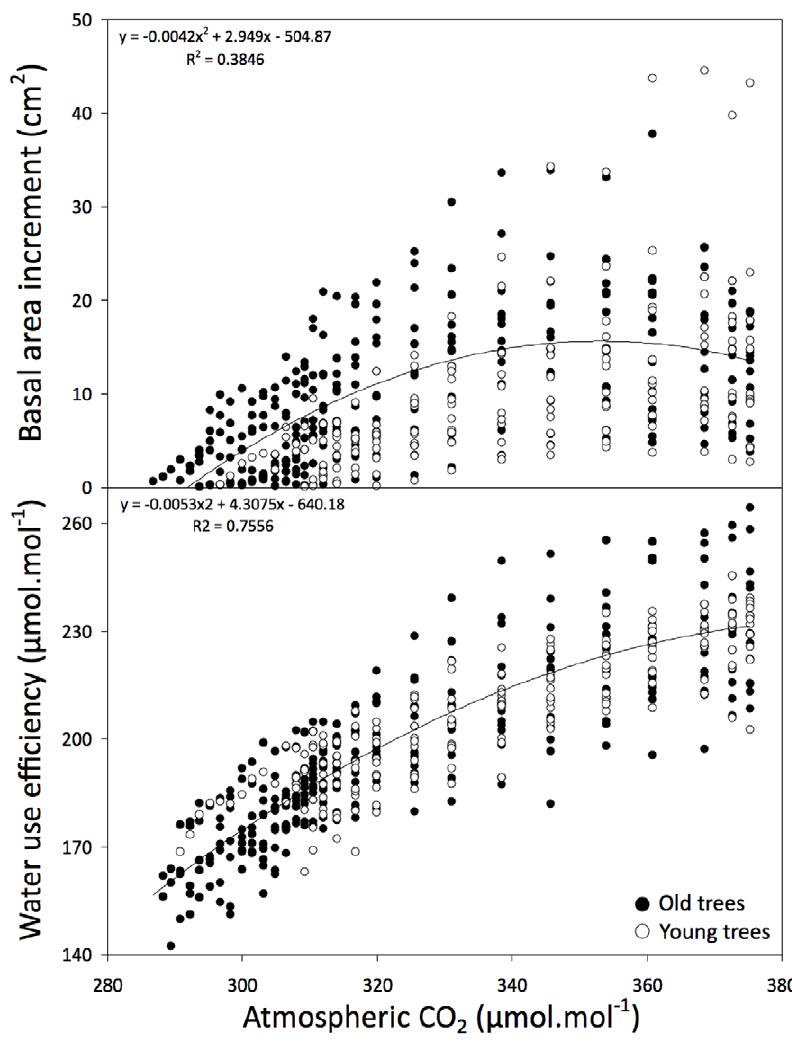
Figure 4. Correlations between atmospheric CO 2 and average basal area increment (BAI) and water use efficiency (WUE) for the five youngest (white circles) and five oldest (black circles) trees from all species and sites. Atmospheric concentrations of CO 2 summarize actual measurements and estimated values from ice cores in Antarctica from 1850 to the present [12].